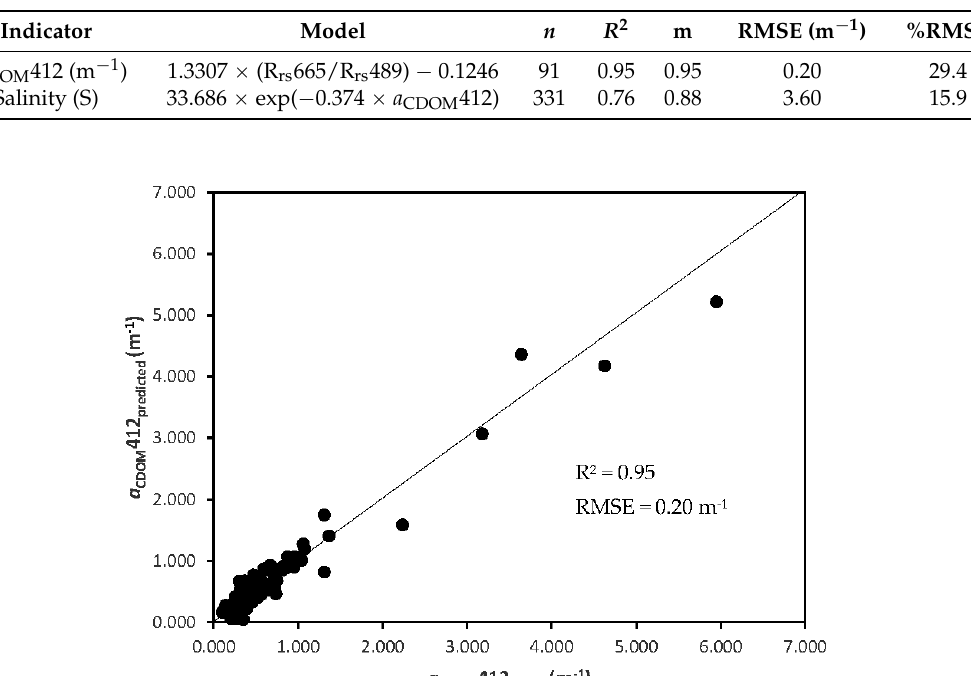
Figure 5. Comparison between ( a CDOM 412) predicted and ( a CDOM 412) measured for water samples ( n = 91)